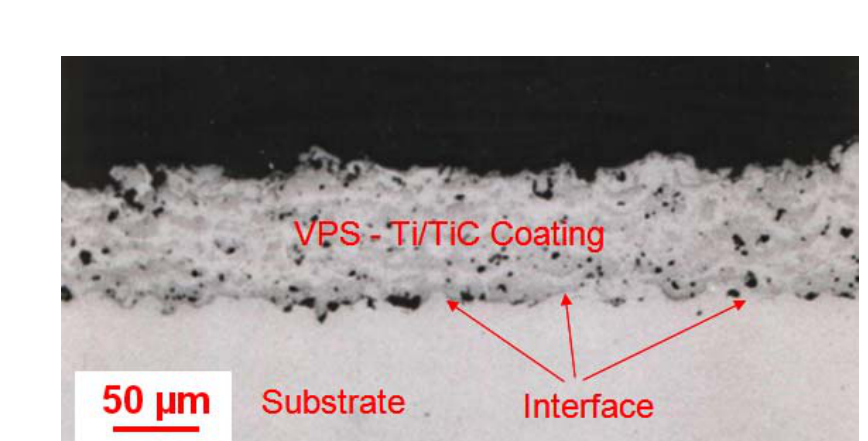
Figure 3 – (OM) Microstructure of the Ti-TiC coating in a deposited state Рис . 3 – (OM) Микроструктура нанесенного покрытия Ti-TiC